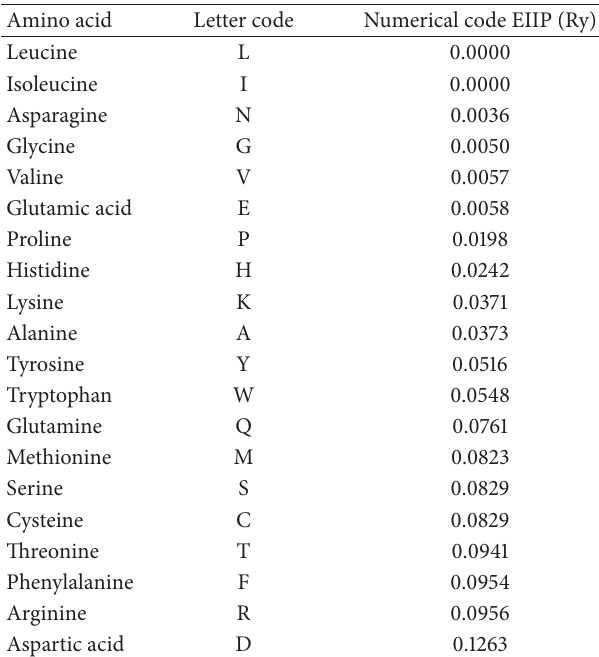
Table 2: Abbreviations and EIIP values for amino acids.